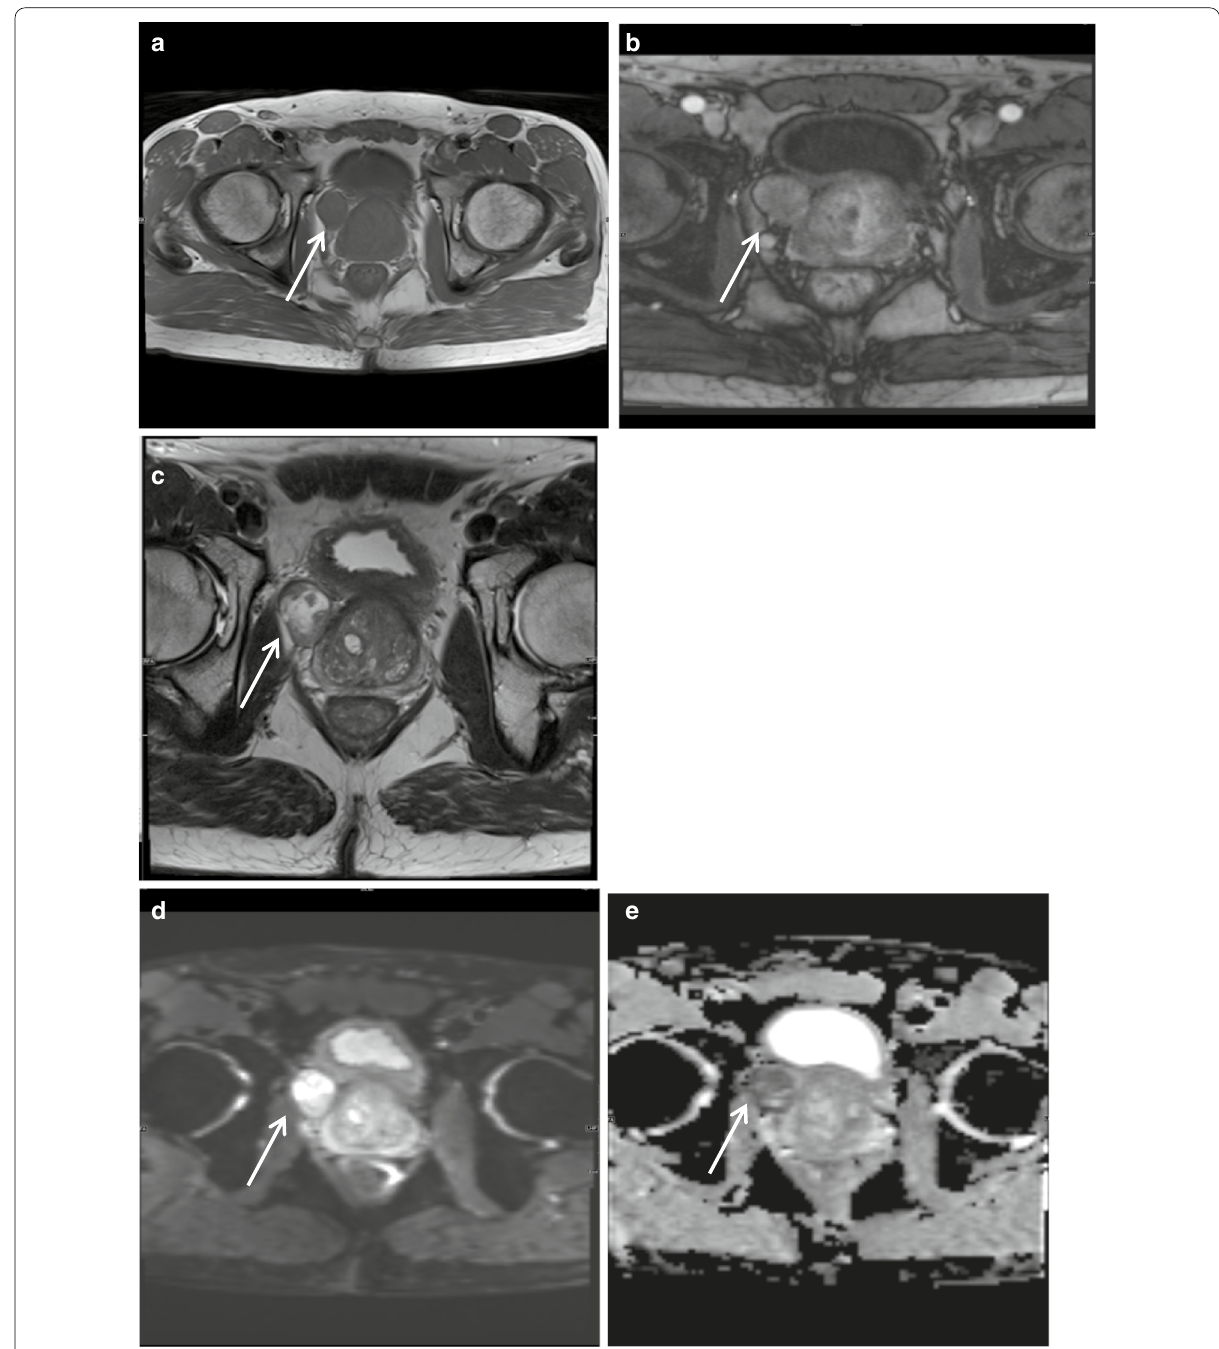
Fig. 11 Periprostatic leiomyosarcoma a , b Axial T1W pre- and post-contrast images, respectively, show a rounded lesion arising from the right anterolateral prostate (white arrow) which is T1 isointense to prostate and shows uniform contrast enhancement. c Is a T2W image showing the lesion is predominantly T2 hyperintense lesion with no convincing invasion of the prostatic capsule. On ( d ) DWI and ( e ) ADC, respectively, the lesion shows restricted